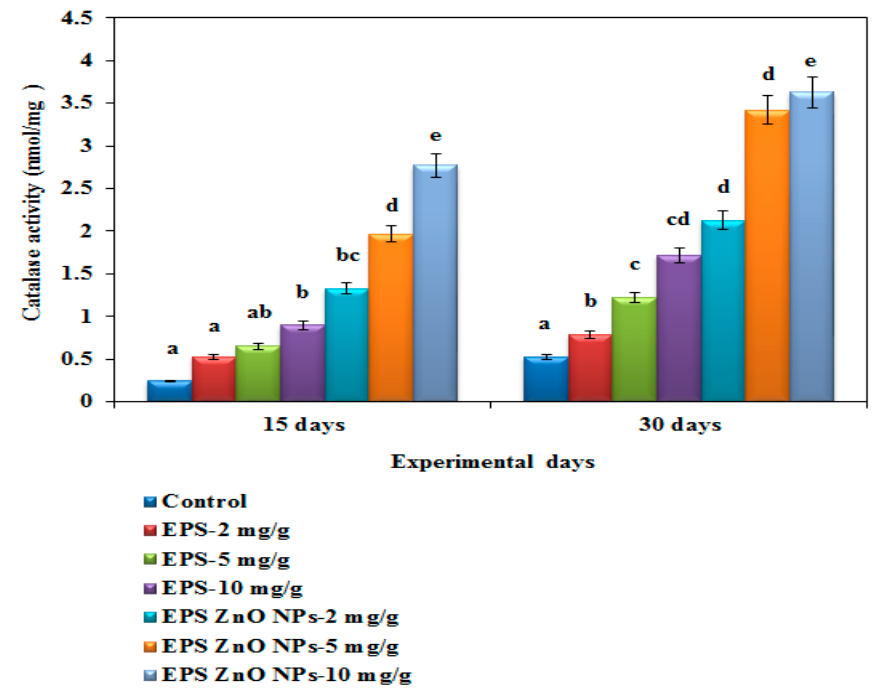
Figure 9. Catalase activity (CAT) of O. mossambicus fed with EPS and EPS-ZnO NPs. T-bars indicate three replicates of mean ± SD, and different letters correspond to the statistical difference between treated groups.